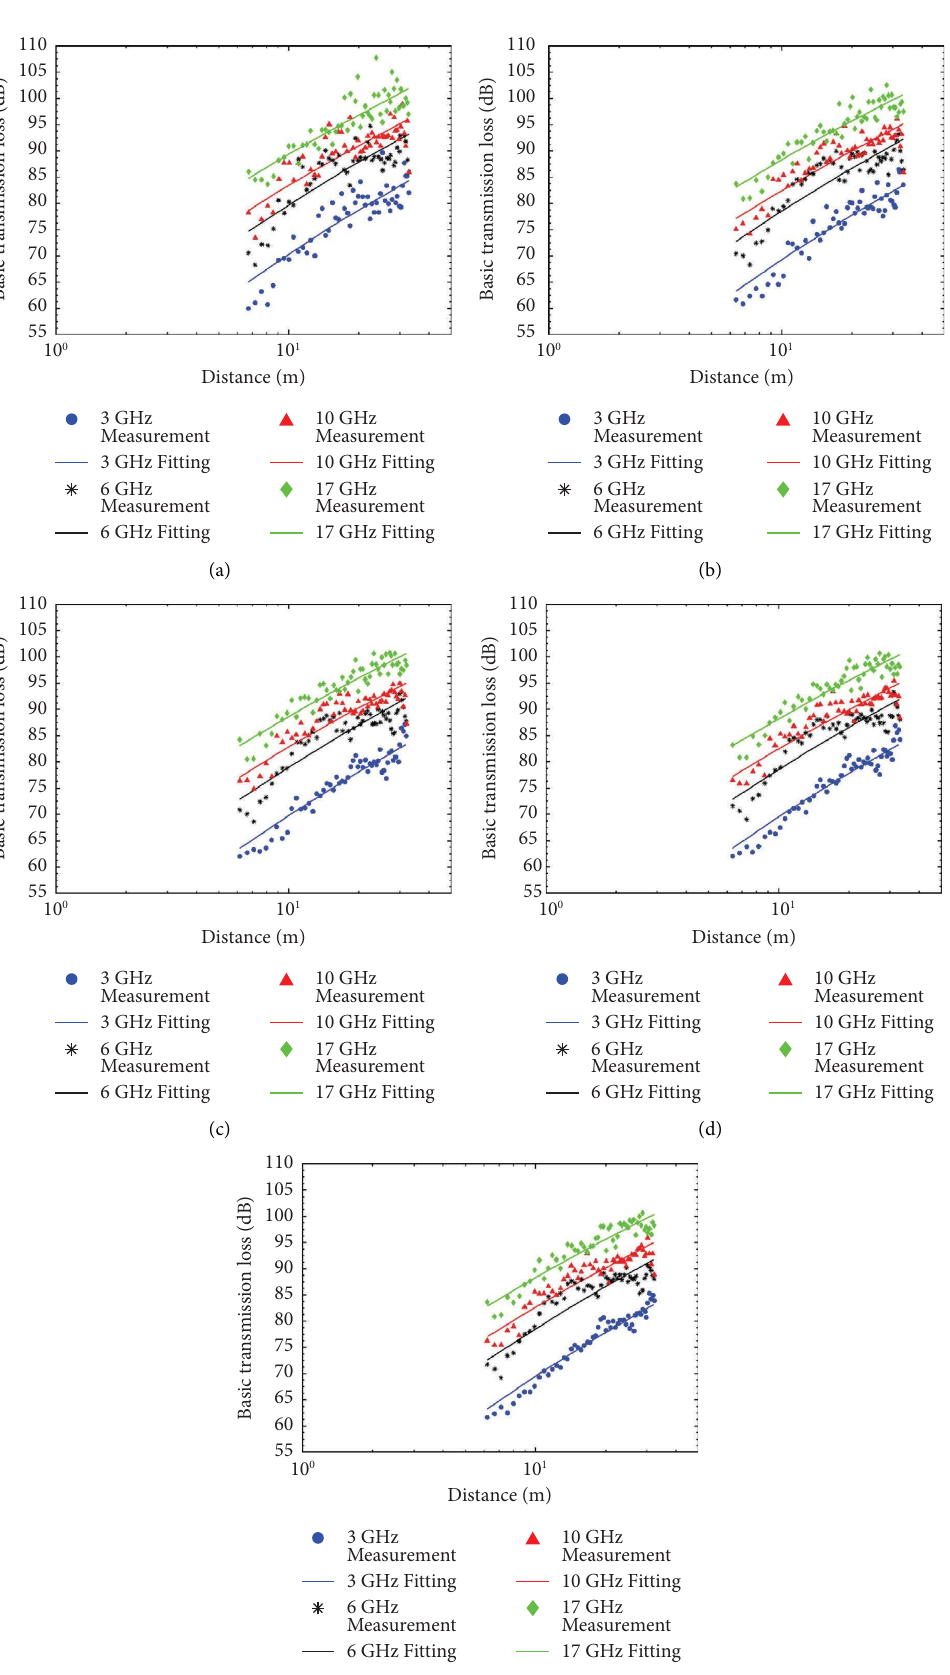
Figure 4: Measurement and ftting results of NLOS. (a) 2 λ . (b) 4 λ . (c) 6 λ . (d) 8 λ . (e) 10 λ